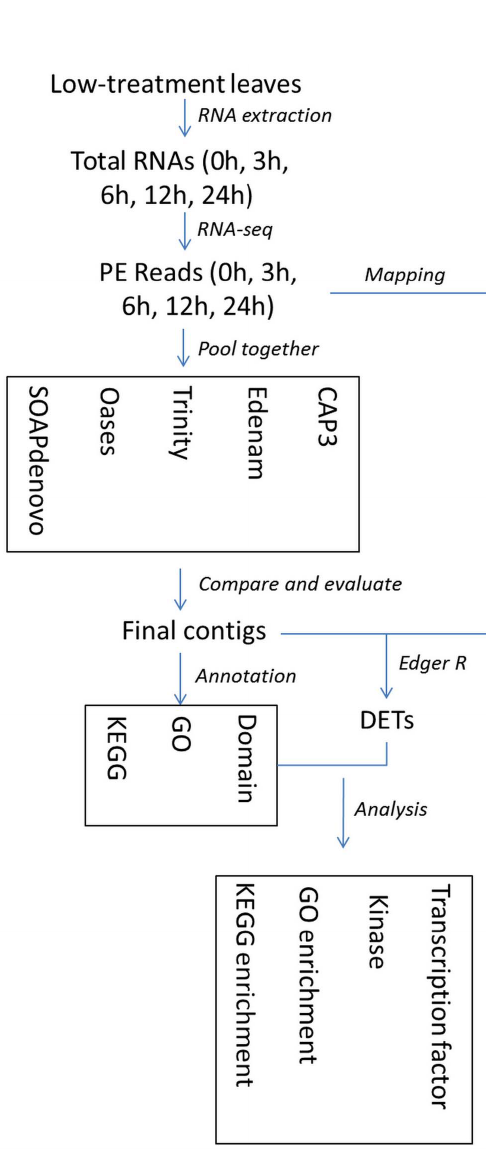
Duration of low temperature (4 6 C) treatment